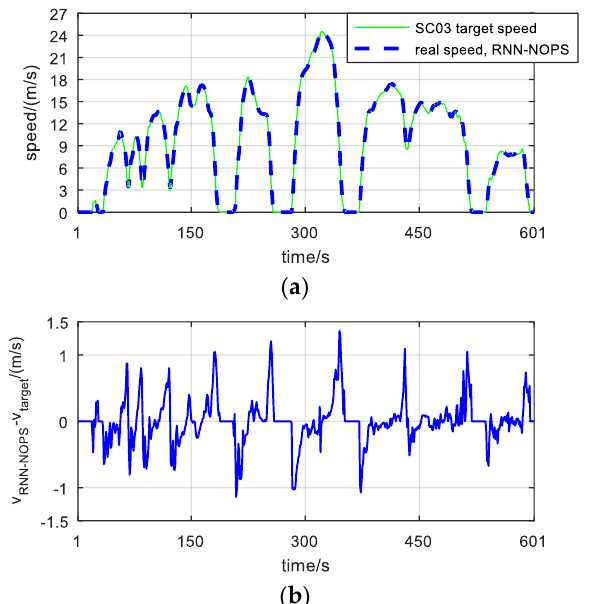
Figure 6. SC03 speed and real speed under control of RNN-NOPS in ( a ), and speed-following error in ( b ).